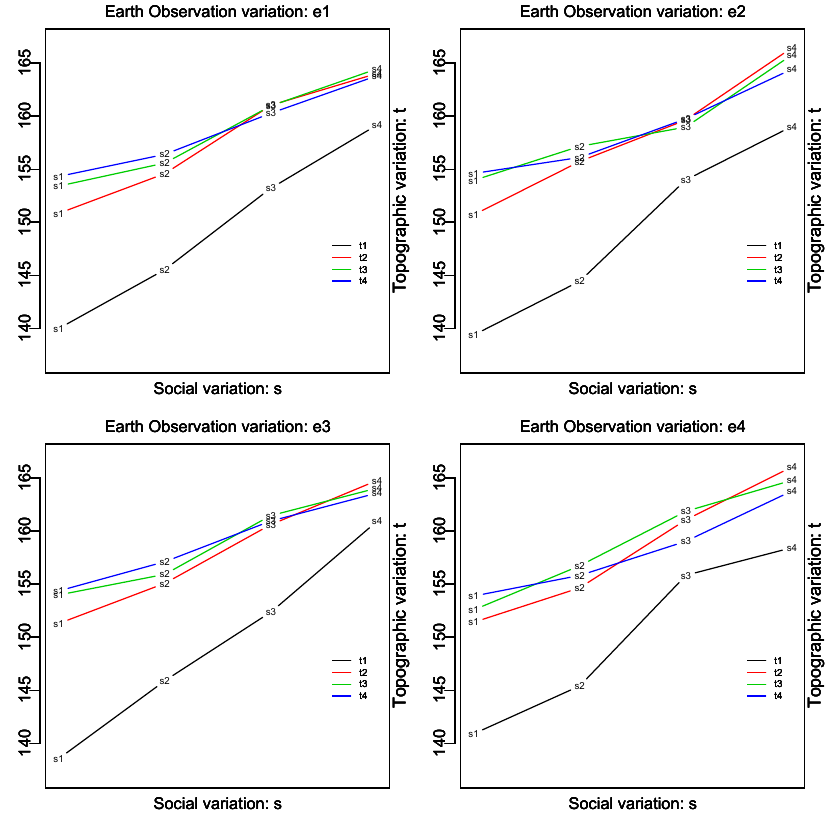
Figure 1. Spatially aggregated output variances for each uncertainty combination level: one-dimensional plots for each s × t level at each e level ( t —topological uncertainty, e —earth observation uncertainty, s —Flickr position uncertainty).